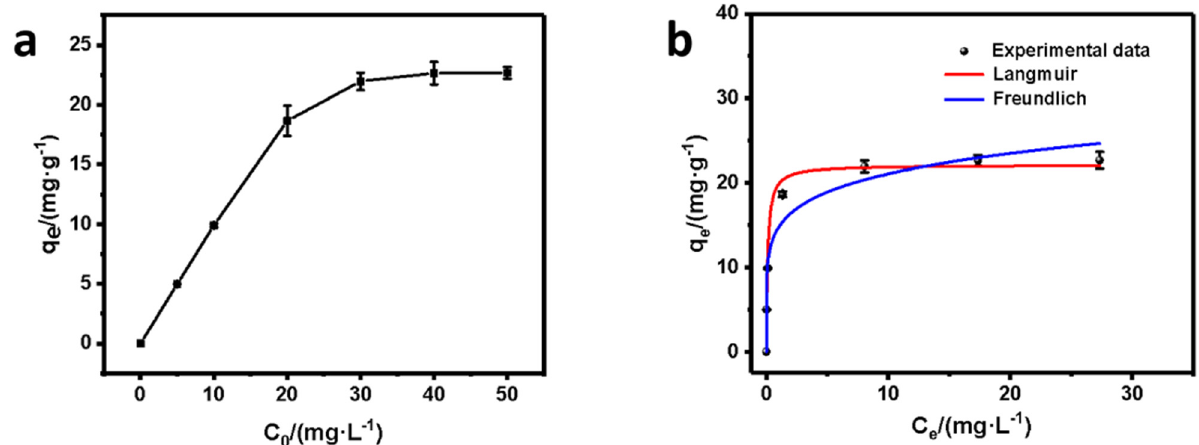
Figure 7. Adsorption isotherms of SP@nZVI. ( a ) Variation of the equilibrium uptake amount with increased initial Cr(VI) concentration. ( b ) Non − linear fitting using Langmuir and Freundlich adsorption models.